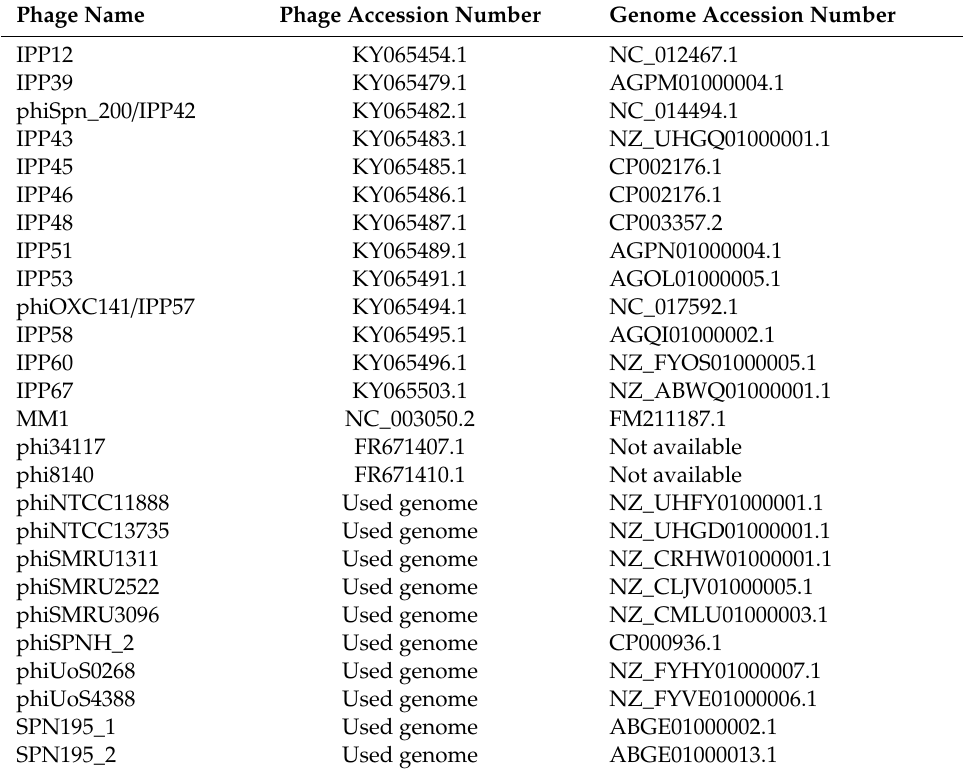
Table A1. Accession Numbers of Phages and Pneumococcal Genome Sequences Used in Figure